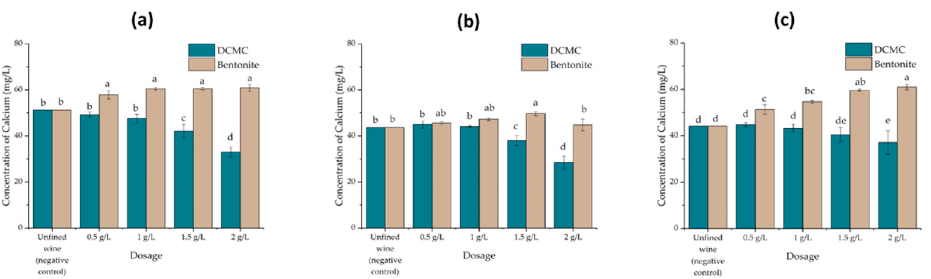
Figure 6. Changes in calcium wine content as determined by ICP-AES on treated and untreated wine samples with increasing amounts of bentonite or DCMC. Different letters represent statistically significant differences among different homogeneous subsets for p = 0.05. ( a ) Encruzado, ( b ) Viosinho, and ( c ) Moscatel de Set ú bal monovarietal